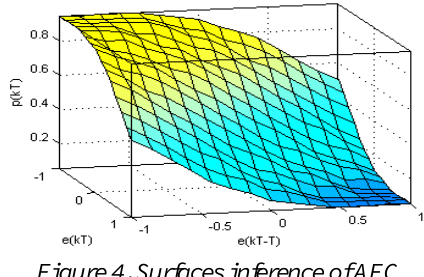
Figure 4. Surfaces inference of